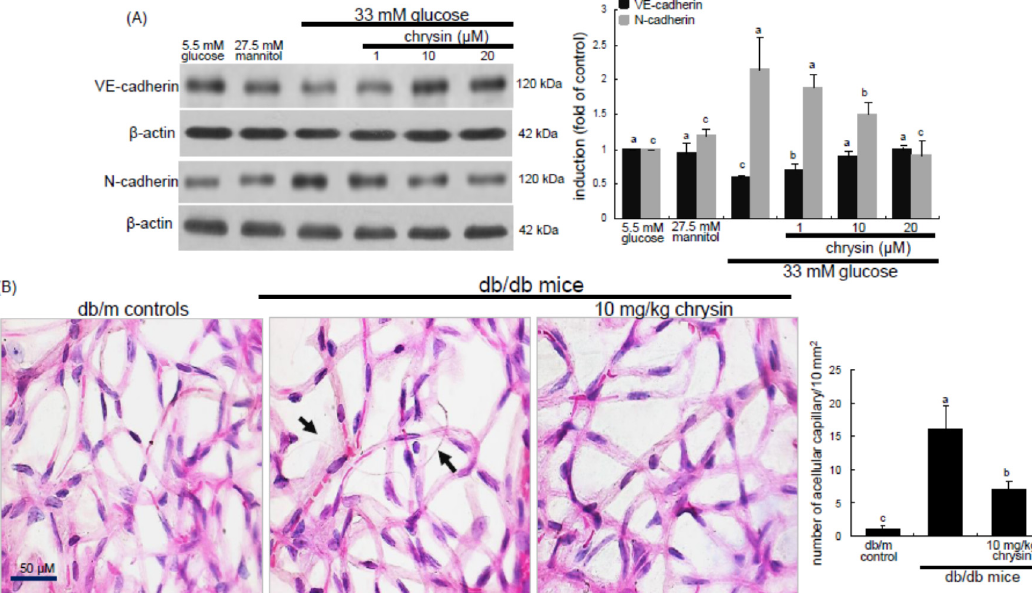
Figure 5. Effect of chrysin on expression of VE ‐ cadherin and N ‐ cadherin in high glucose ‐ exposed HRMVEC ( A ) and histopathological changes in trypsin ‐ digested retinal vessels ( B ). HRMVEC were incubated with 33 mM glucose in the absence and presence of 1–20 μ M chrysin up to five days. Cells were also incubated with 5.5 mM glucose and 27.5 mM mannitol as osmotic controls. Cell lysates were subject to Western blot analysis using a primary antibody against VE ‐ cadherin or N ‐ cadherin ( A ). β‐ actin protein was used as an internal control. Bar graphs (mean ± SEM, n = 3) in the right panels represent densitometric results of left blot bands. The db/db mice were orally treated with 10 mg/kg chrysin for 10 weeks, and db/m mice were introduced as control animals. Retinal vessels were stained with H&E stain ( B ). Acellular capillaries (red arrow) were observed in db/db mice. Magnification: 200×. The number of acellular capillaries was measured to assess the extent of retinopathy. Values in bar graphs (mean ± SEM, n = 3) not sharing a common letter differ, p < 0.05.